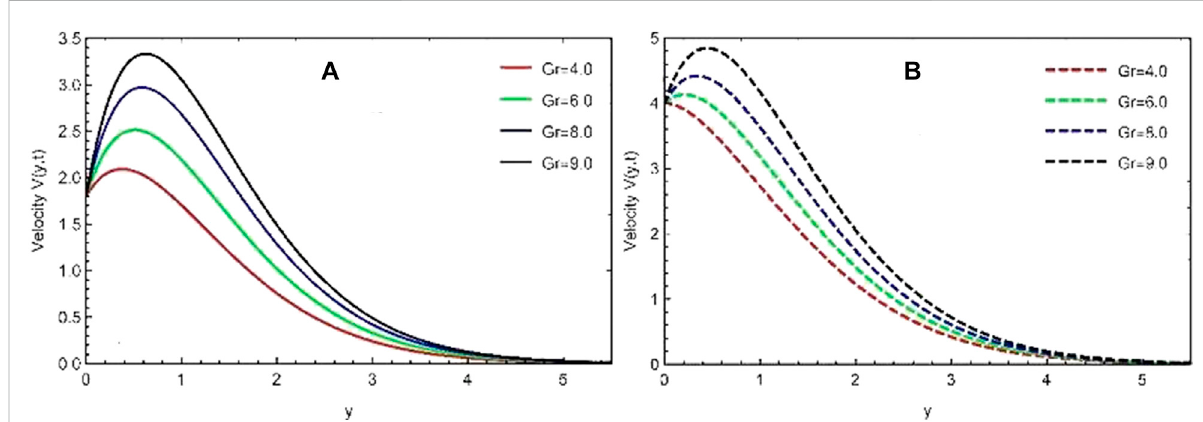
FIGURE 7 Velocity plot for Gr with α (cid:3) β (cid:3) γ (cid:3) 0 . 8 , Pr (cid:3) 11 . 4 , β 1 (cid:3) 1 . 4 , ( a ) : t (cid:3) 1 . 97 ; and ( b ) : t (cid:3)